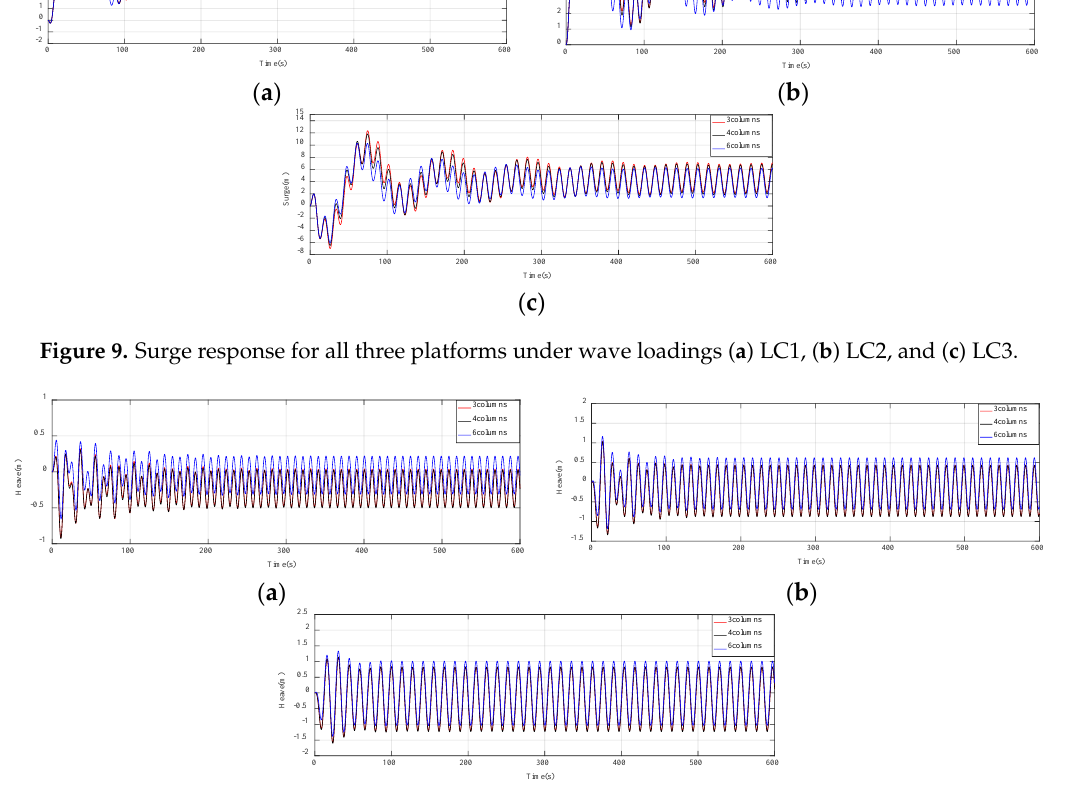
Figure 9. Surge response for all three platforms under wave loadings ( a ) LC1, ( b ) LC2, and ( c ) LC3.